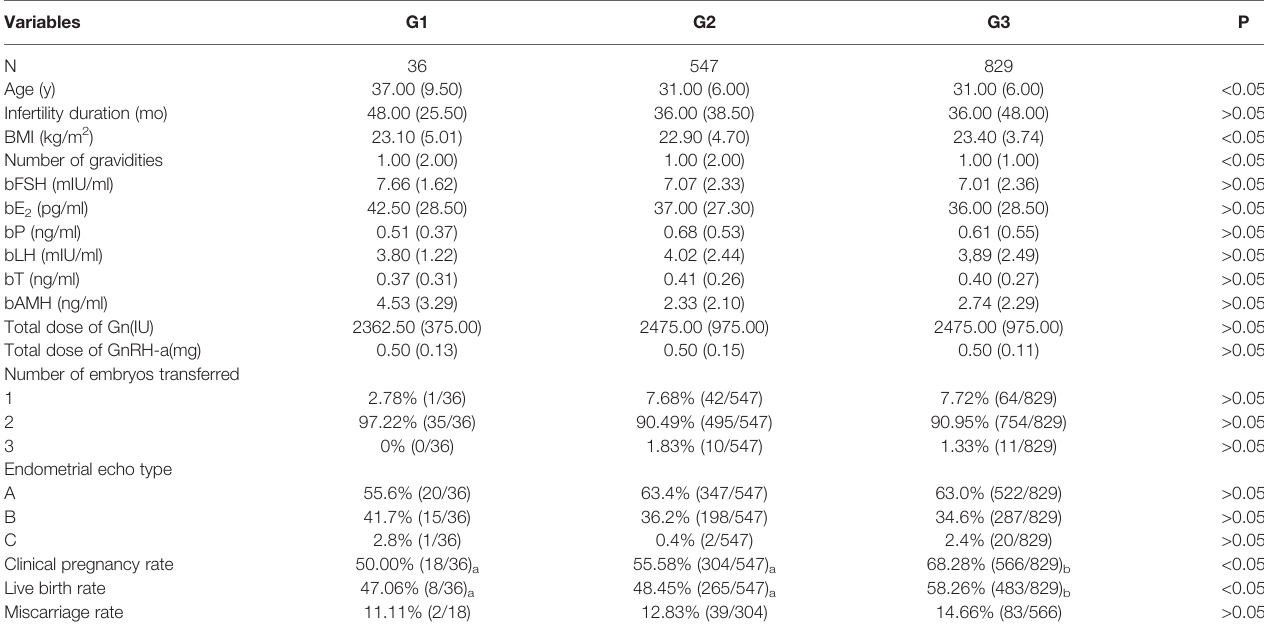
TABLE 3 | Clinical data and pregnancy outcomes in subgroups of GnRH-a long protocol.